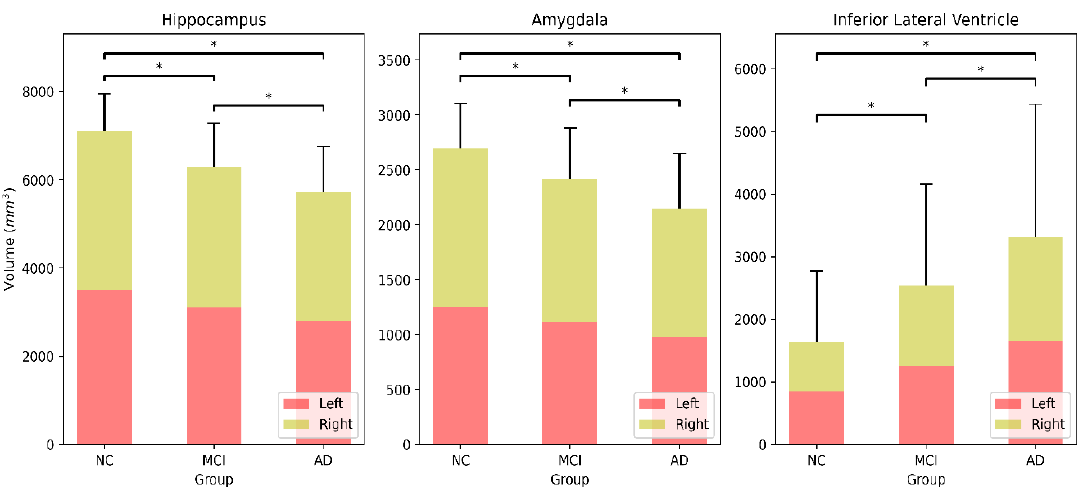
Figure 5. Regional volume of hippocampus, amygdala, and inferior lateral ventricle for NC, MCI, and AD groups. Statistical significance is marked with * ( p < 0.05).